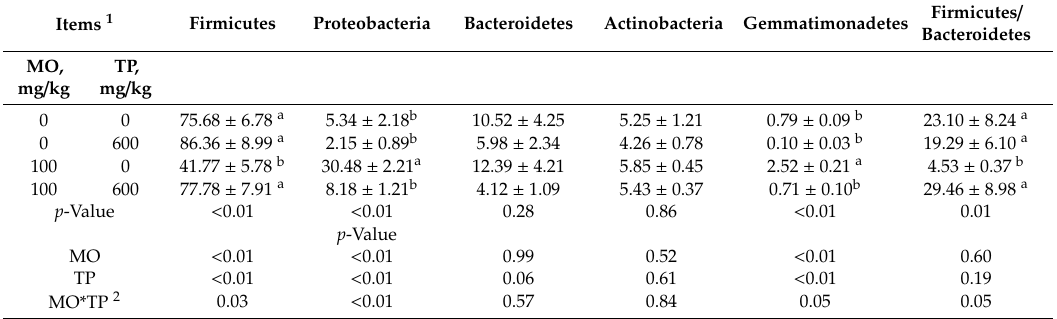
1 Each mean represents 5 cages, with 2 layer/cage. Abbreviations represented: TP = tea polyphenols; MO = molybdenum. 2 MO*TP means the interaction between MO and TP. a,b Means in the same column with different letters differ significantly ( p < 0.05).